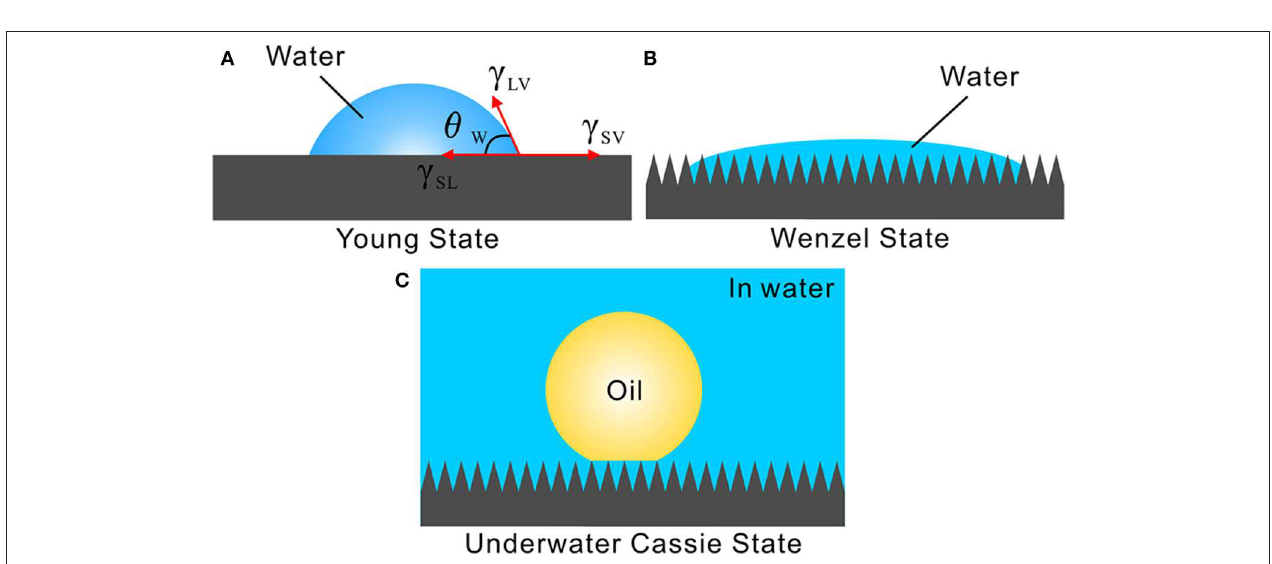
FIGURE 3 | Different wetting states and the formation mechanism of underwater superoleophobicity. (A) Young wetting state. (B) Wenzel wetting state. (C) Underwater Cassie state for achieving underwater superoleophobicity.